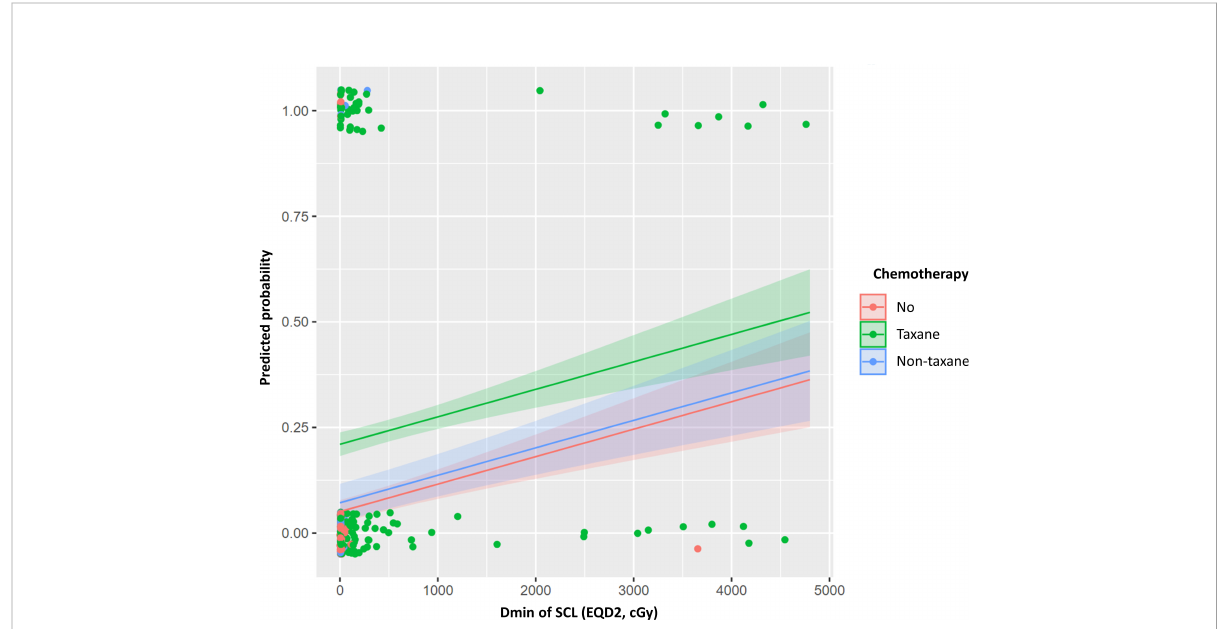
FIGURE 2 Predicted probability curve of clinical + dosimetric model II for lymphedema risk within 3 years after postoperative radiotherapy. Dmin, minimum dose; EQD2, equivalent dose in 2 Gy ( a / b =3); SCL, supraclavicular lymph